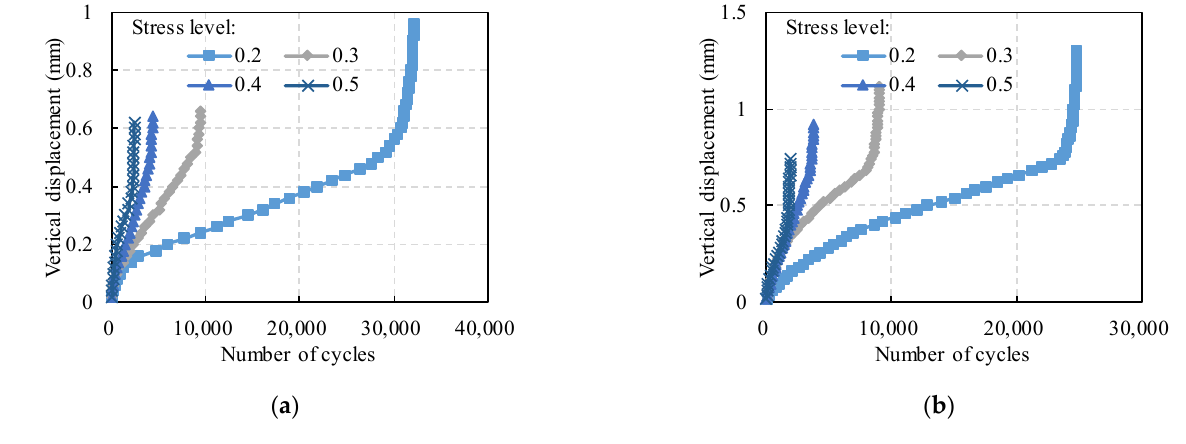
Figure 3. Displacement changes of SCB fatigue test: ( a ) ER–PC; ( b ) PU–PC.